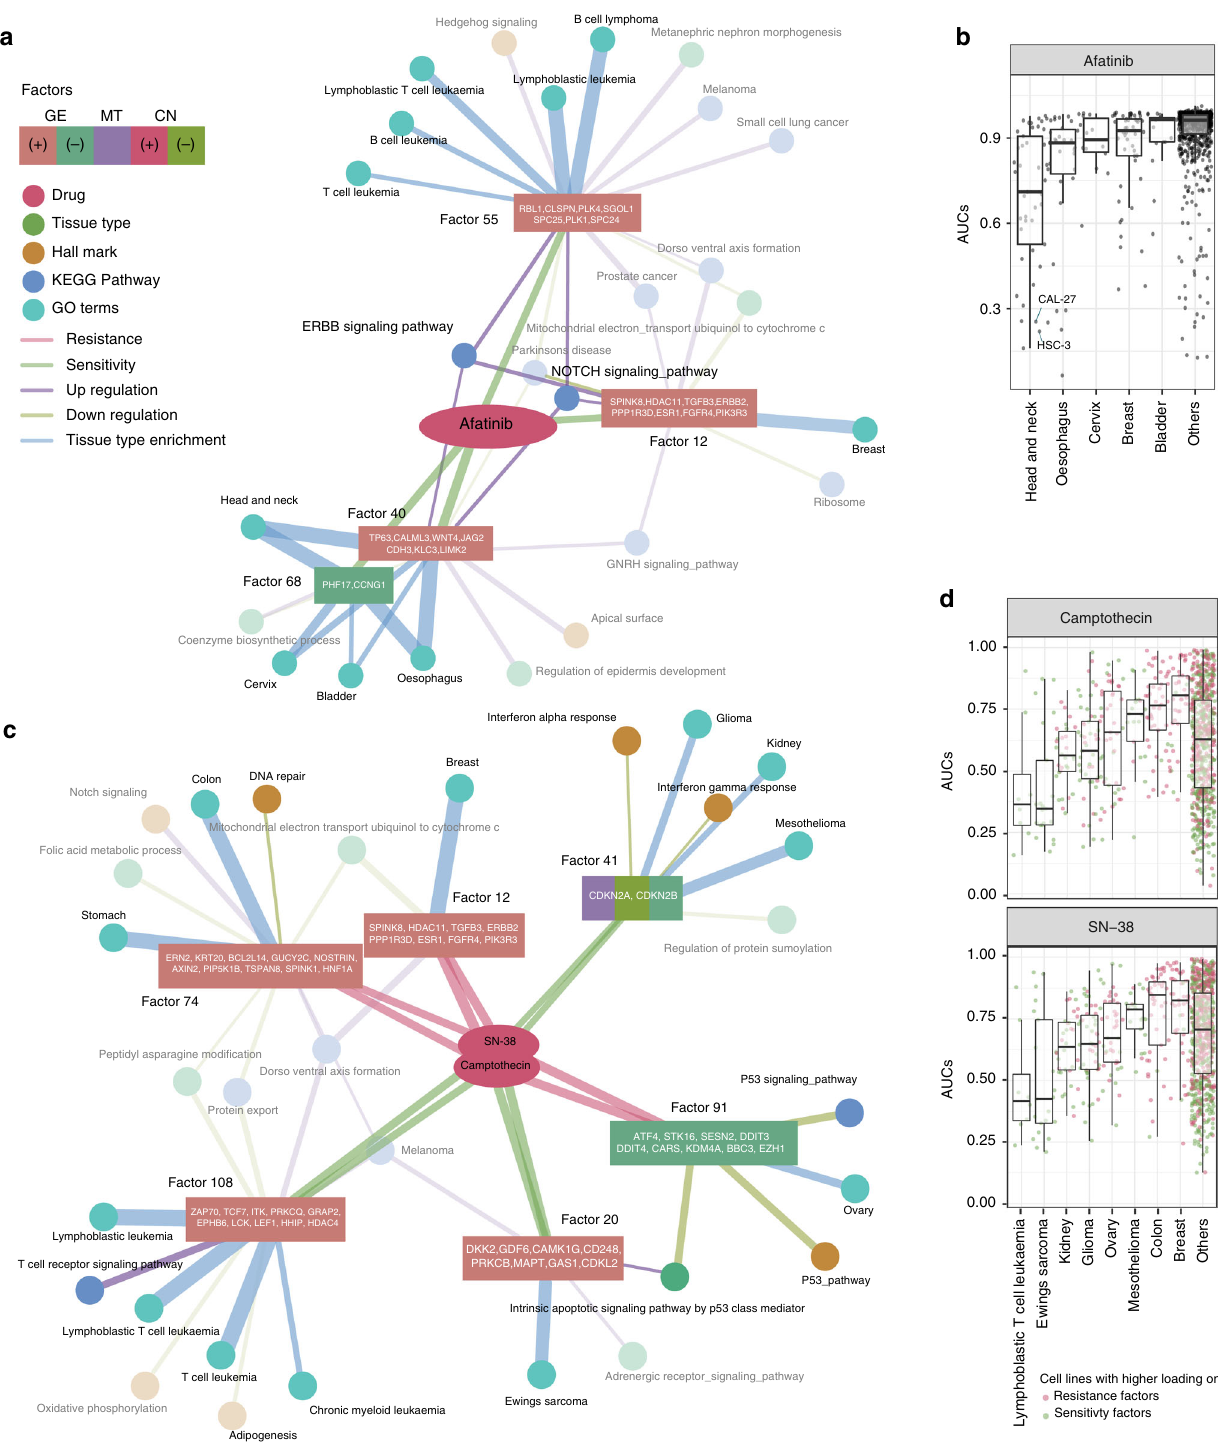
Fig. 4 Network-based combined interpretation of factors that explain drug responses. a Top factors (square nodes) explaining the response to Afatinib (BIBW2992; pink node) with their associated tissue types (green nodes) and functions (dark yellow, blue and blue-green nodes) in a network. Listed in the corresponding node are the top genes from each factor indicating the factor. The types of node and edges are denoted by colors indicated in the fi gure. The nodes mentioned in the text are highlighted. b Afatinib response of cell lines by tissue types highlighted in a . Two sensitive head and neck cancer cell lines (CAL-27 and HSC-3) are indicated. Standard notations are used for elements of the boxplot (i.e. upper/lower hinges: 75th/25th percentiles; inner- segment: median; and upper/lower whiskers: extension of the hinges to the largest/smallest value at most 1.5 times of interquartile range). c Top factors that explain the response to TOP1 inhibitors, SN-38 ( Irinothecan ) and Camptothecin represented in a network (format as in a ). d Camptothecin (top panel) and SN-38 ( Irinotecan ; bottom panel) response of cell lines by tissue types highlighted in c . Color of nodes indicates higher loading in sensitive factors (green) and resistance factors (red) for each cell line. Standard notations are used for elements of the